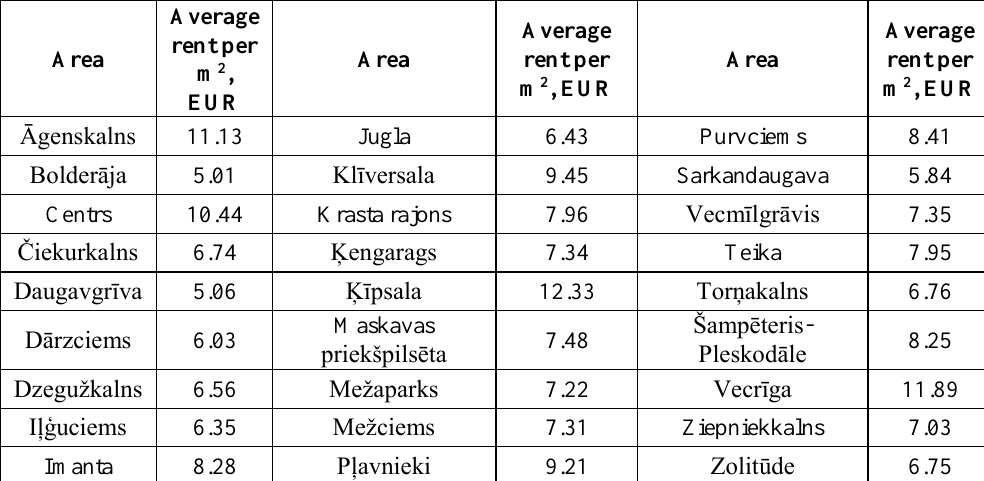
Table 1. Average Rent per m 2 per Month in EUR in 27 Administrative Areas of Riga, Latvia (developed by the authors, based on Renting prices, 2018)